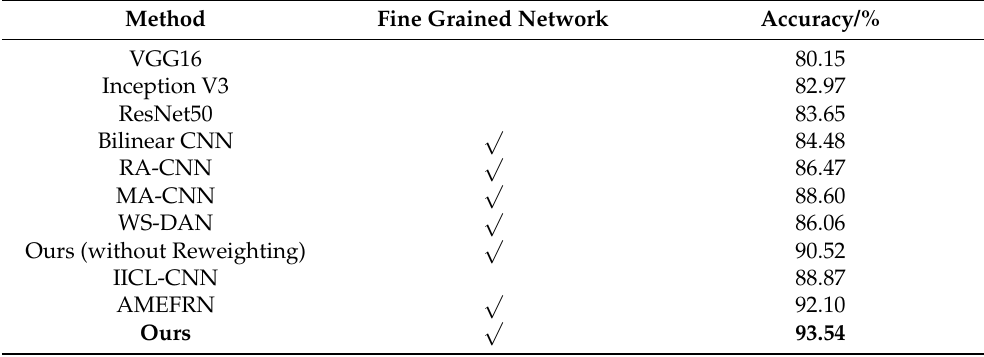
Table 8. Compared with other state-of-the-art methods on FGSC-23 dataset. A check mark in the second column indicates that the method is a fine-grained method. Bold values indicate best